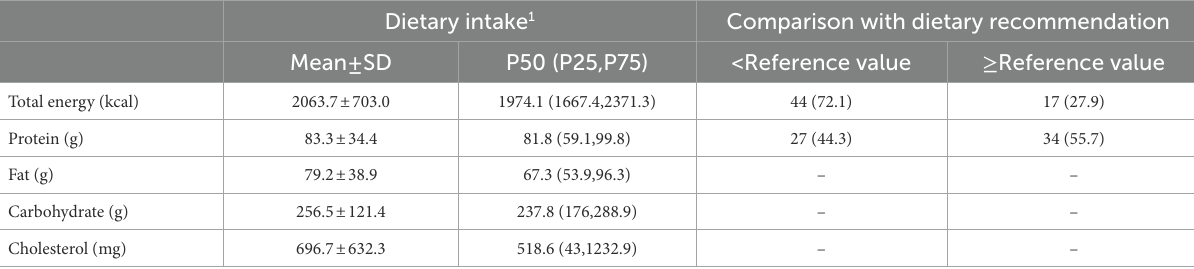
TABLE 2 Dietary intake of lactating mothers.